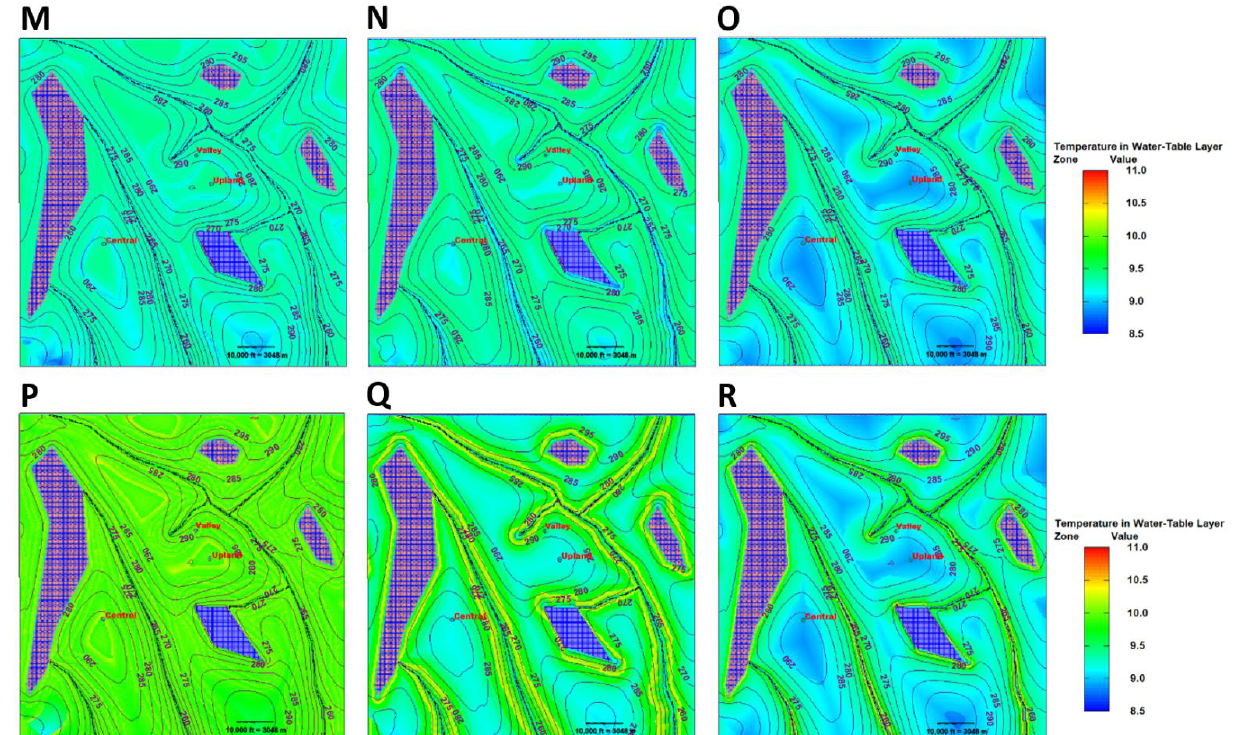
Figure 4. Simulated heads (contour lines) and temperatures (color-filled) for the water table layer through time for the NO_UZ_THK ( A , D , G , J , M , P ), MID_UZ_THK ( B , E , H , K , N , Q ) and HI_UZ_THK models ( C , F , I , L , O , R ). Water table temperatures are shown for ( A – C ) end of spin-up, ( D – F ) after 2.75 years of warm-up, ( G – I ) after 10.17 years of warm-up, ( J – L ) after 15.17 years of warm-up, ( M – O ) after 24.67 years of warm-up, and ( P – R ) after 25.67 years of warm-up. Additional details for each subplot are provided in Table 3. Table 3. Additional information pertaining to subplots shown in Figure 4.